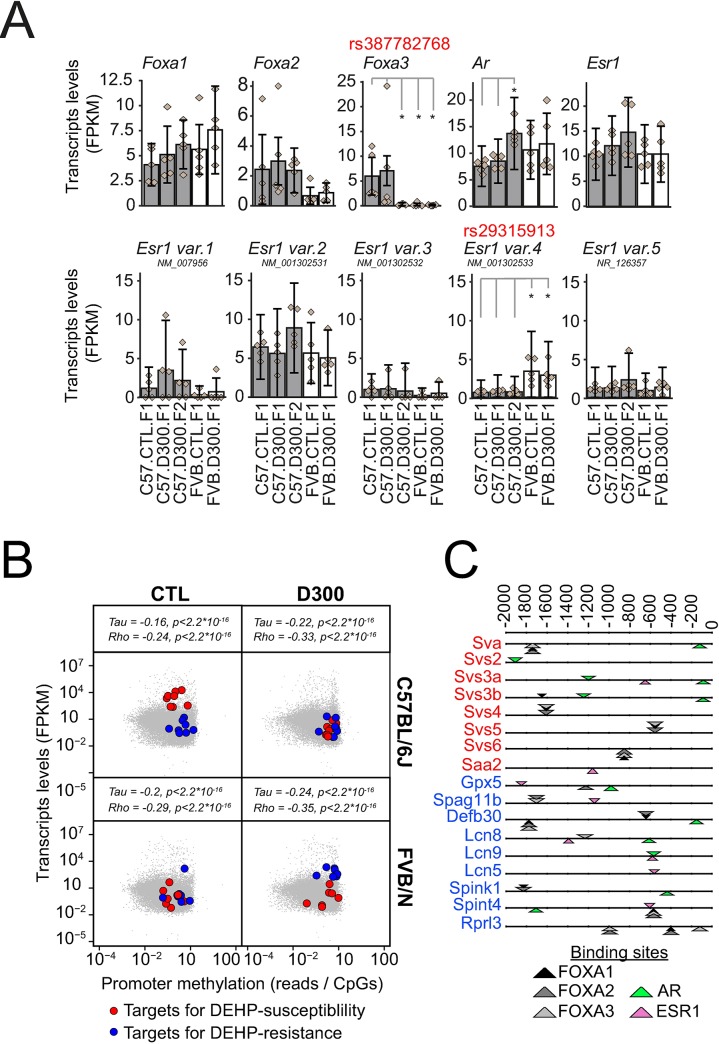
Sexual hormone signaling differs between FVB/N-resistant and C57BL/6J-susceptible strains.(A) Impact of non-synonymous SNP on SHP key players. Expression levels for FOXA1-3 transcription factors, as well as for AR and ESR1, across the five experimental conditions. C57BL/6J-derived data are shown as gray bars and FVB/N derived data as white bars. Error bars represent the CummeRbund computed confidence intervals. Diamonds show the individual FPKM values of the replicates. Data were produced by all RNA-seq. Non-synonymous rs387782768 in FOXA3 and rs29315913 SNP in ESR1 variant 4 were characterized previously [23]. Stars represent statistically significant differences of expression levels according to the non-parametric pairwise Wilcoxon test with Benjamini & Hochberg correction for multiple testing. (B) Promoter methylation and RNA expression in the sperm of the F1 generation of C57BL/6J (up) and FVB/N (down) mice subjected to prenatal exposure to corn oil vehicle (CTL, left) or to DEHP (D300, right) were analyzed in quintuplicates. Promoter methylations were obtained by MBD-seq [11] and were normalized to the number of CpG sites in 2.2 Kb. Correlations were assessed using Kendall’s tau and Spearman’s rho rank correlation tests. Blue points represent the genes showing the pattern of DEHP-resistance involving Gpx5, Spag11b, Defb30, Lcn8, Lcn9, Lcn5, Spint4 and Rprl3, that was absent in the MBD-seq, but without 9230104L09Rik. Red points represent the genes showing the pattern of DEHP-susceptibility involving Sva, Svs2, Svs3a, Svs3b, Svs4, Svs5, Svs6, Spink1 and Saa2, without Pate4 and 950003J23Rik, both absent in MBD-seq. (C) Binding sites for AR (green), ER (pink) and FOXA1-3 transcription factors (black, dark gray and white) detected in promoters of genes associated with DEHP-susceptibility (red names) and DEHP-resistance (blue names). The number of AR (n = 6) binding sites were higher than ER (n = 2) sites in promoters of genes (n = 8) silenced by DEHP in C57BL/6J and associated with susceptibility. Equal numbers of ER (n = 6) and AR (n = 6) binding sites were detected in the genes (n = 9) induced by DEHP in FVB/N and associated with resistance. Binding sites are shown as triangles orientated differently depending on the DNA strands and with thickness reflecting the score. Sequences were extracted from -2000 to 0 bp with gene names from Mus musculus GRCm38. Analysis was performed using the matrix-scan program of Rsat [111].